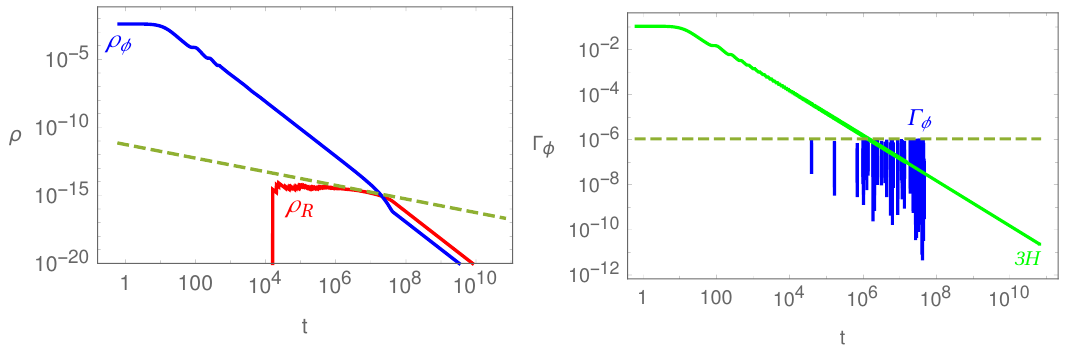
Figure 3 . Numerical solution of the coupled in(cid:13)aton and radiation equations of motion for M 1 = 5 (cid:2) 10 (cid:0) 5 M P , h = 1 and (cid:21) = 10 (cid:0) 3 . In the left plot we show the time evolution of the in(cid:13)aton and radiation energy density, the dashed green line representing the analytical behaviour derived in eq. (4.26). In the right plot we give the comparison between the Hubble parameter and the in(cid:13)aton decay width, the dashed line giving the maximum value of the decay width per oscillation period. Results are given in Plank